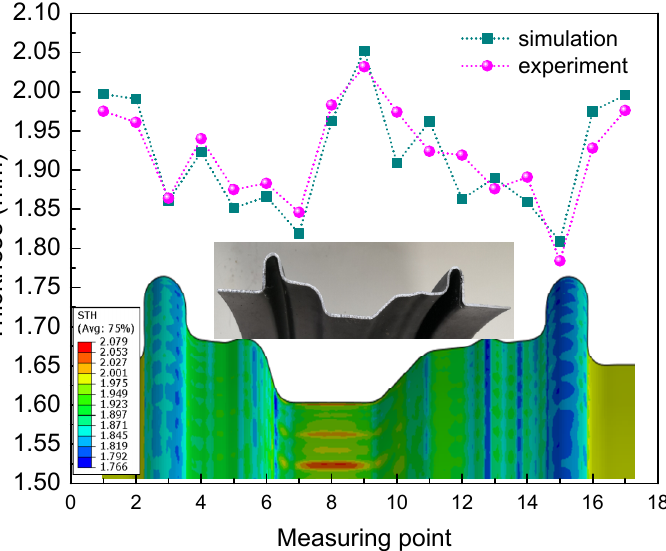
Figure 25. Comparison between the simulation thickness distributions and experimental results along the axial direction of the rim.